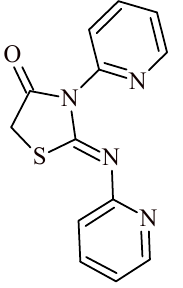
Figure 5. The thiazolidin-4-one-benzothiazole hybrids with antioxidant activity. Carraro Junior et al. conducted evaluation of 3-(pyridin-2-yl)-2-(pyridine-2-ylimino)thiazolidin-4-one (PPIT) for their antioxidant activity and inhibition potential of monoamine oxidase (MAO) [24]. The studies demonstrated that PPIT (Figure 6) has antioxidant and reducing activity according to the ABTS, DPPH, FRAP and PC assays. Additionally, PPIT selectively inhibited the activity of cerebral MAO-B isoform in concentration equal to or greater than 200 µM. The compound PPIT inhibited MAO-A isoform in none of the tested concentrations.